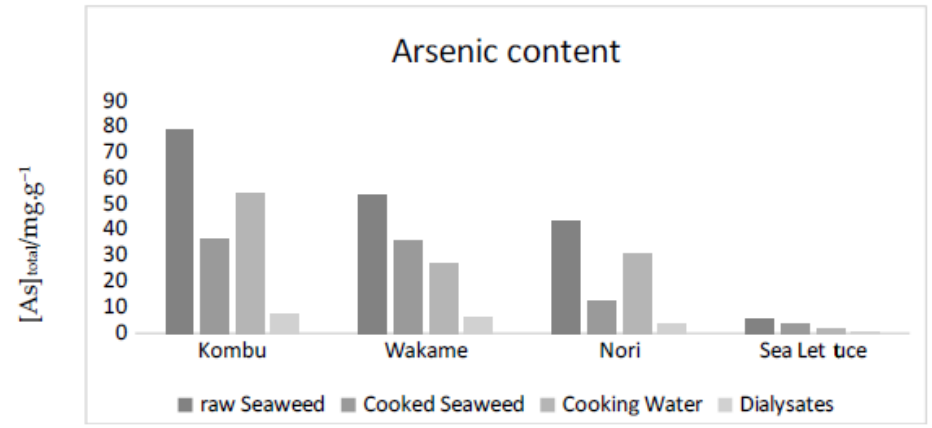
Figure 1. Total arsenic concentrations in kombu, wakame, nori and sea lettuce seaweed samples before and after being cooked, and in their cooking water and dialysates obtained after subjecting these cooked seaweeds to an in vitro gastrointestinal digestion [39].